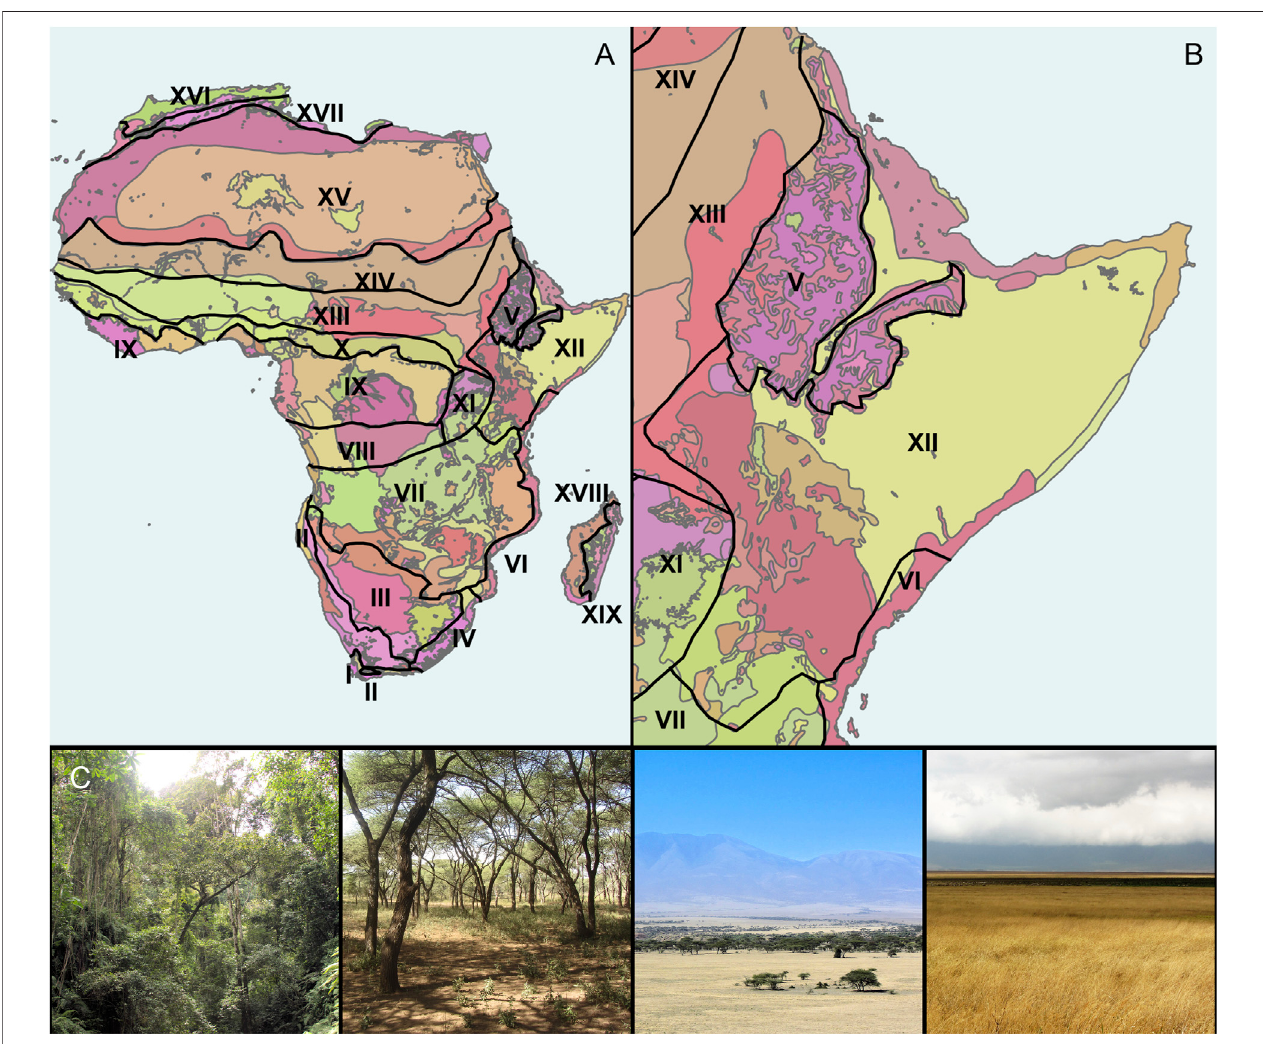
FIGURE 1 | Different scales of plant landscape variability. (A) Biomes as de fi ned by White ’ s (1983) African phytochoria (supplementary information for classi fi cations) overlain on African ecoregions as delineated by the World Wildlife Federation (WWF) (Olson et al., 2001); (B) Eastern African biomes and ecoregions with focusonWhite ’ sSomalia-MaasaiRegionalCenterofEndemism(XII).Notethenumerousanddiverseecoregionswithinthelargerphytogeographicbiomes. (C) Different habitat types that can be found throughout the Somalia-Maasai Regional Center of Endemism. From left to right: forest, woodland, wooded grassland, and grassland. Table 1 for a synopsis of main habitat